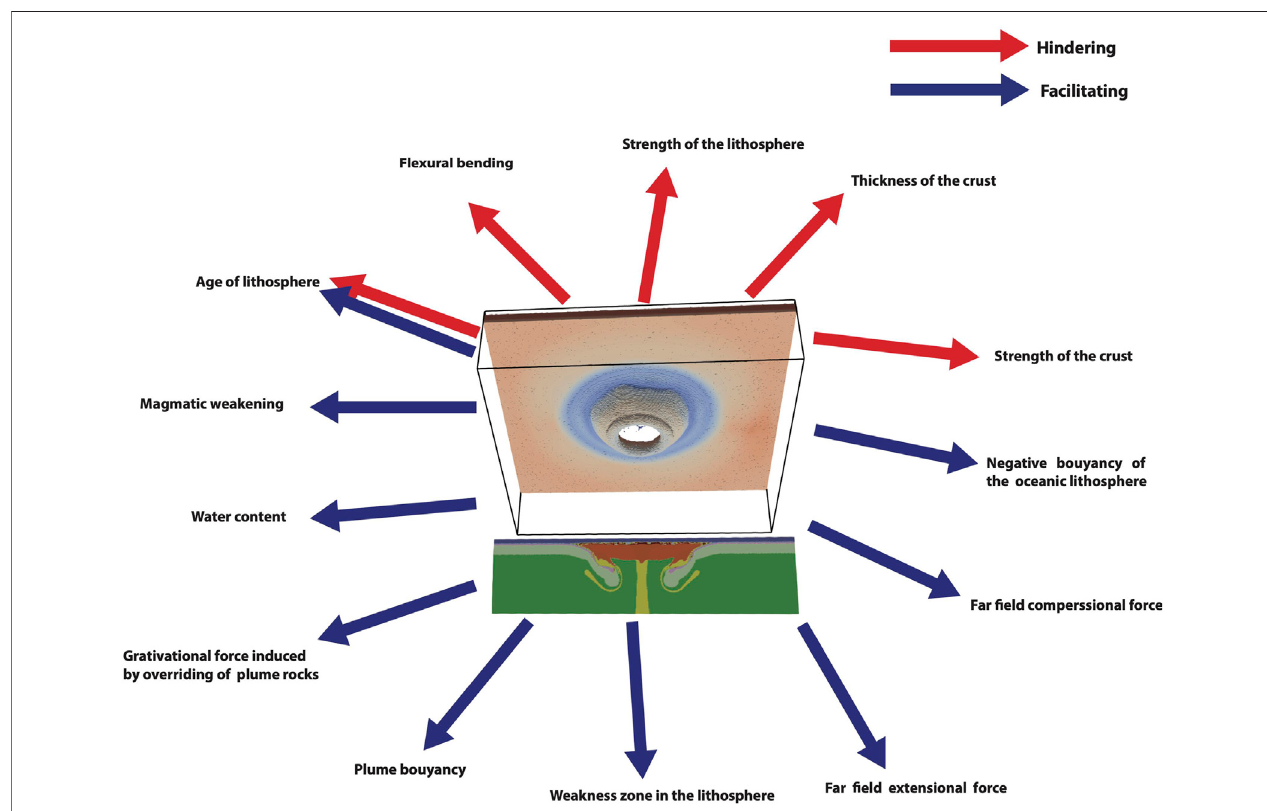
FIGURE 15 | Synopsis of hindering and facilitating parameters in plume-induced subduction initiation. Note that aging of the lithosphere has a dual effect; aging increases lithospheric strength, which hinders subduction initiation, but it can also facilitate subduction initiation because it increases lithospheric density.